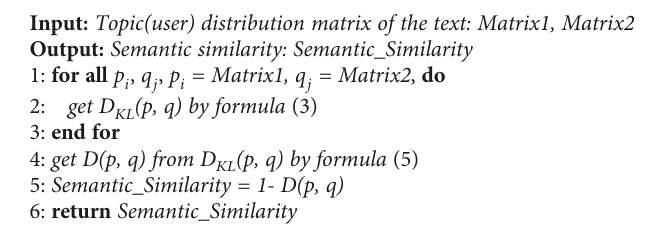
Algorithm 4: Calculation of the semantic